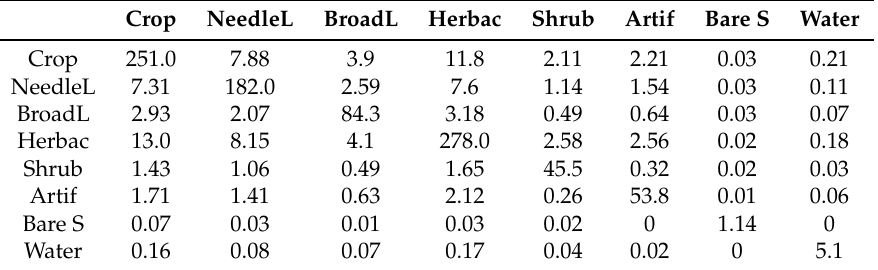
Table A12. Confusion matrix for the reference with error values proportional to (j,k) class frequencies and overall accuracy of 95%. Crop NeedleL BroadL Herbac Shrub Artif Bare S Water Crop NeedleL BroadL Shrub